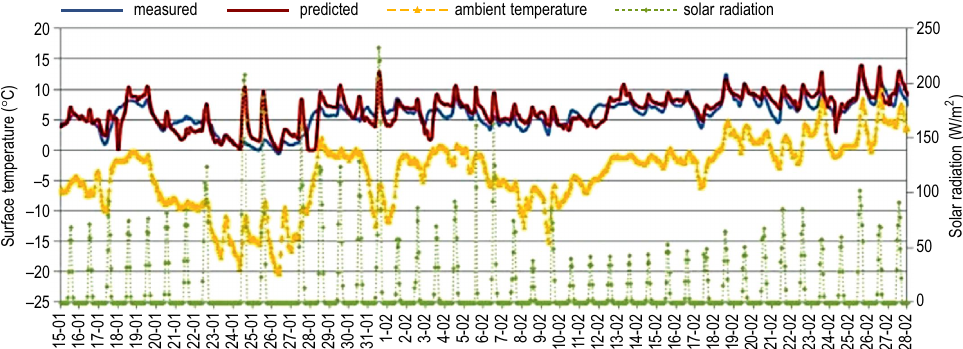
Fig. 7. Measured and predicted average surface temperature with ambient temperature and solar radiation